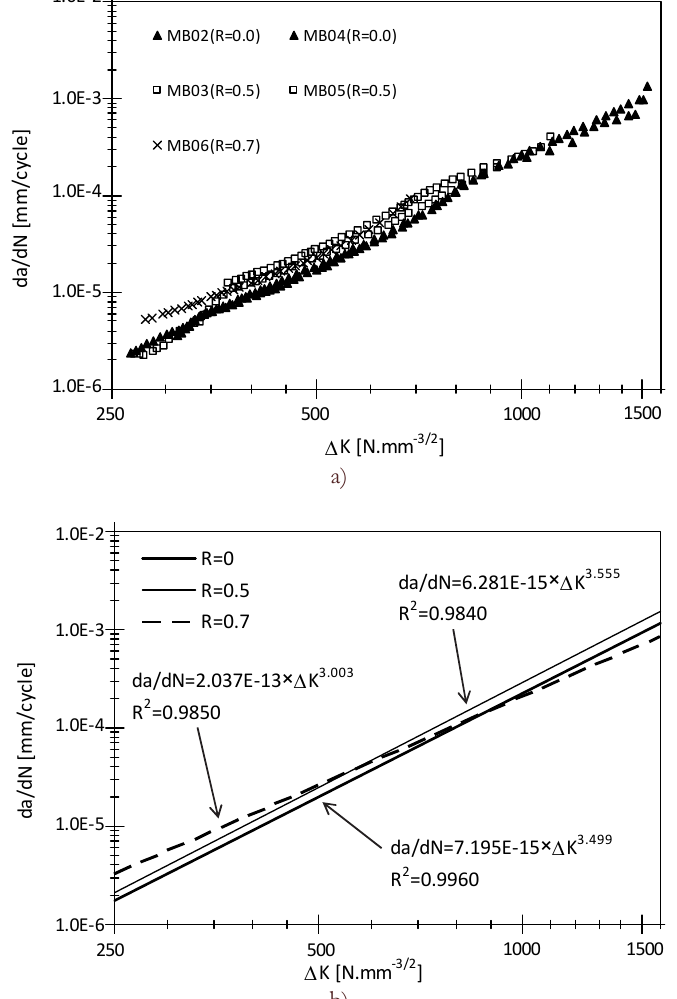
Figure 1: Fatigue crack growth data of the P355NL1 steel: a) Experimental data; b) Paris correlations for each stress R